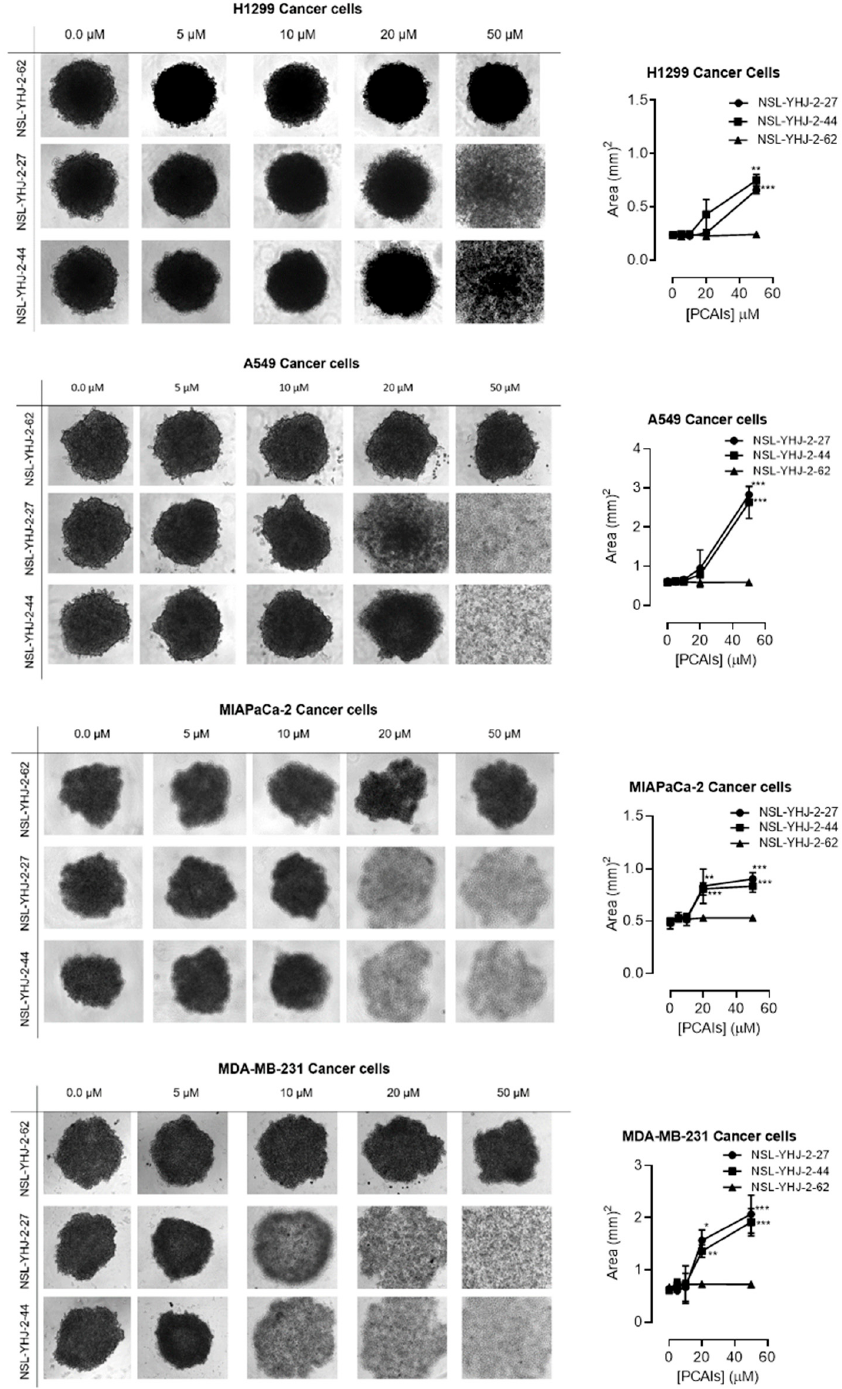
Figure 3. PCAIs induce the degeneration of 3D spheroid cultures. Cells were seeded in Nunclon Sphera 96-well, U-shaped-bottoms microplates and allowed to grow and form compact spheroids overnight. They were then treated with the indicated concentrations of the respective PCAIs for 48 h. The effects of the PCAIs were captured using the Nikon Eclipse Ti 100 inverted microscope (4× magnification) with Nikon DS Qi2 camera. At higher concentrations of PCAIs, the spheroids disintegrate. The effect of the PCAIs on spheroid cultures was quantified by measuring the areas of the spheroid bodies using the NIS-Element software. The results are the mean ± SEM, n = 3. Statistical significance (** p < 0.01 and *** p < 0.001) was determined using one-way ANOVA with post hoc Dunnett’s tests.